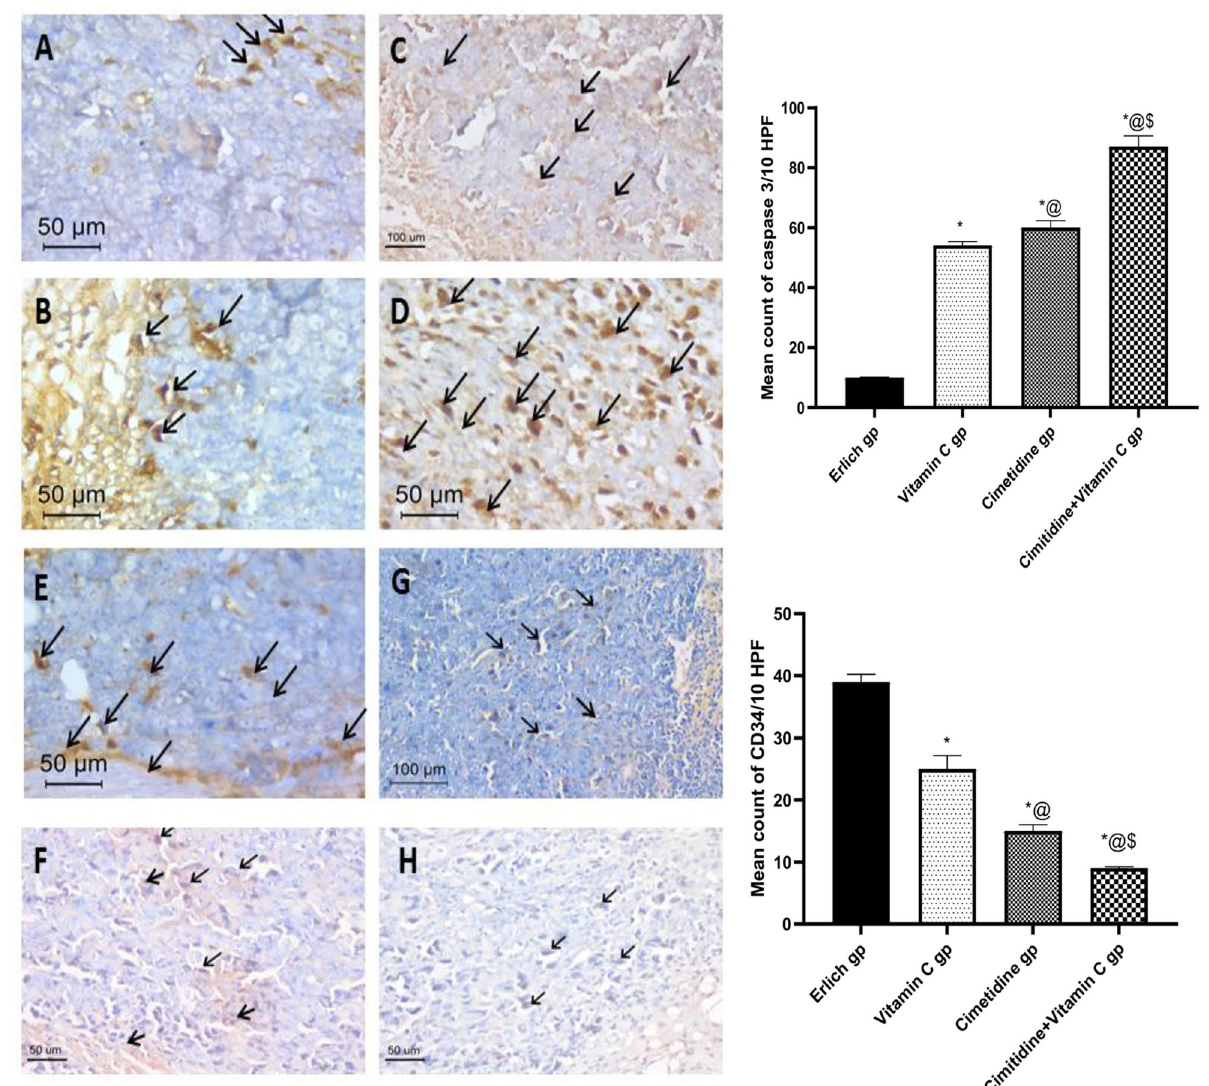
Figure 13. The changes in the caspase 3 and CD34 immunostain in Ehrlich induced breast solid tumor in untreated mice and different treated groups with cimetidine at a dose of 200 mg/kg/day, vitamin C at a dose of 4 g/kg/day, and their combination for 15 days. Data are presented as mean ± SD.* Significantly different from the normal control group, P < 0.05. @ is significantly different from Ehrlich untreated group, P < 0.05. $ is significantly different from the vitamin C- treated group, P < 0.05. # is significantly different from the cimetidine-treated group, P < 0.05. ( A ) shows caspase 3 immunostain within the tumor of untreated mice. ( B – D ) Shows caspase 3 immunostain within the tumor after treatment with vitamin C, cimetidine, and the combination therapy, respectively. ( E ) shows CD34 immunostain within the tumor of untreated mice. ( F – H ) reveals CD34 immunostain within the tumors after treatment with vitamin C, cimetidine, and the combination therapy, than vitamin C, reaching a mean count of 15/10HPF (Fig. 13G). The combination therapy caused the most significant reduction in the CD34, reaching a mean count of 9/10HPF (Fig. 13H). Statistical correlations. Statistical correlations were performed using the Spearman coefficient test to investigate the association between mast cell mediators (histamine, VEGF, and TNF-α) and members of the PI3K/AKT/mTOR pathway, apoptosis, and angiogenesis within cimetidine and vitamin C treated group. The results of the statistical correlations revealed a positive correlation between mast cell mediators (histamine, VEGF, and TNF-α) and each of PI3K, AKT, mTOR, PKA, IRS1, and CD 34. On the other hand, a negative cor- relation was observed between mast cell mediators (histamine, VEGF, and TNF-α) and caspase-3 levels within the TME (Table 5). The proposed mechanisms of the correlations and the proposed mechanism of action of cimetidine and vitamin C are summarized in (Fig. 14).